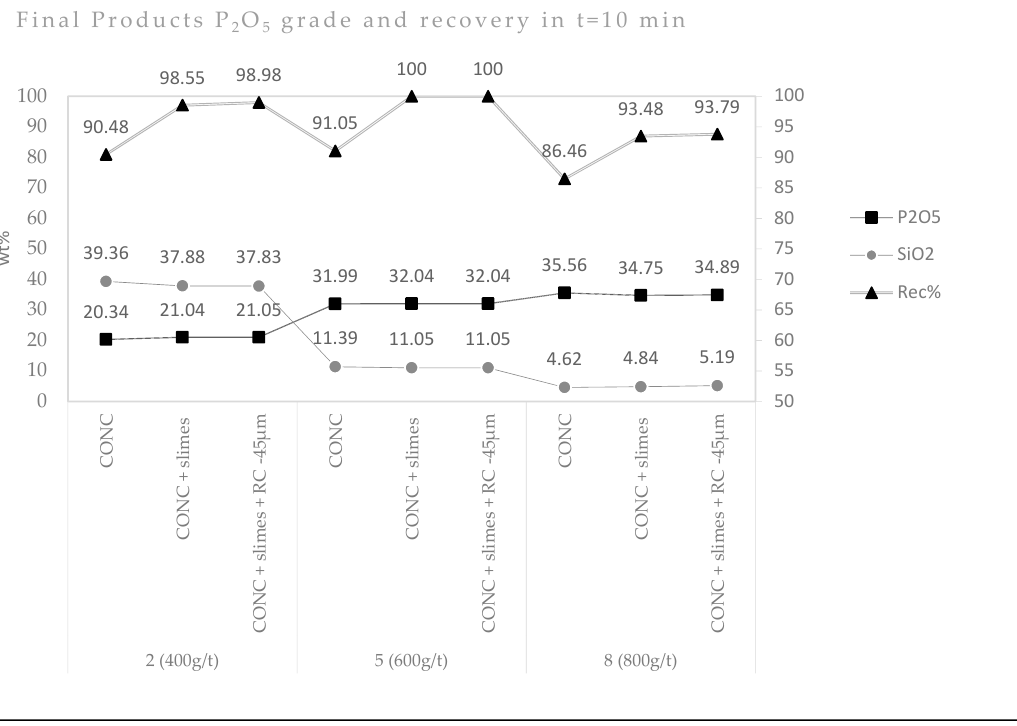
Figure 9. Grades and recovery changes in tests 2, 5, and 8 for the final product ( t = 10 min).